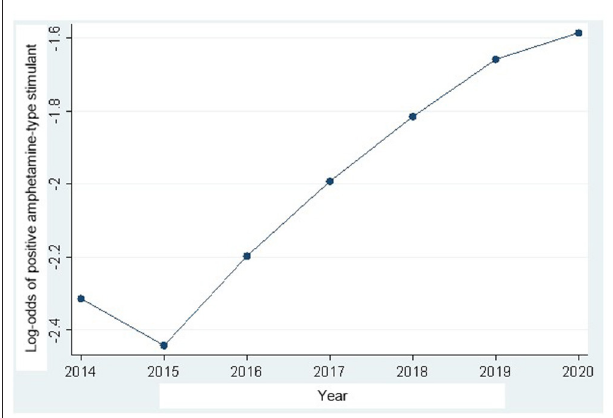
FIGURE 1 | Amphetamine-type stimulant urine drug screening (UDS) results trajectory in Ontario Canada from 2014 to 2020 (detailed results available in Table 2 ).